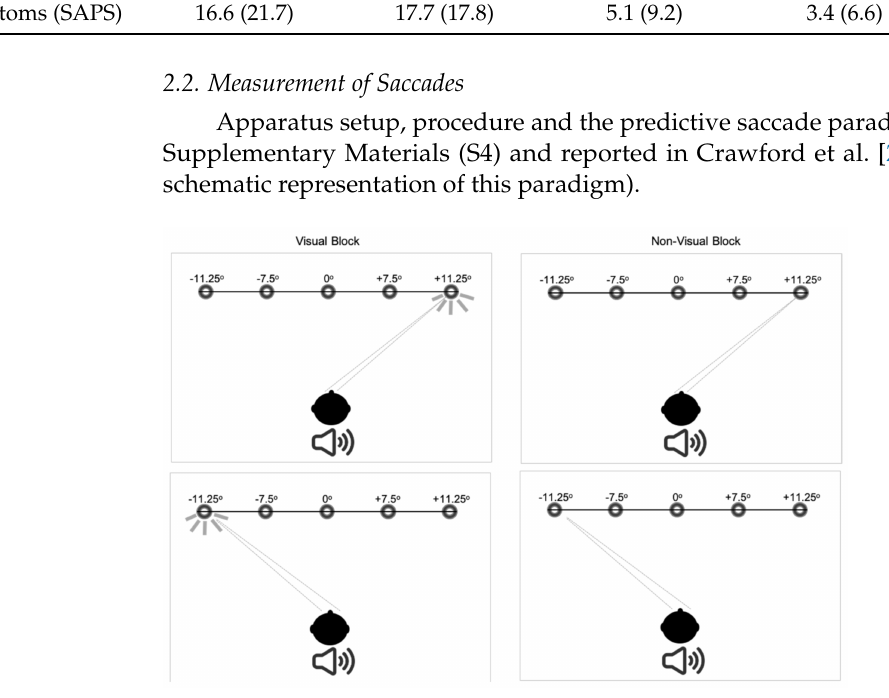
Figure 1. Saccadic target paradigm for the predictive saccade task. See text for full description of the target configuration and the subject instructions in each